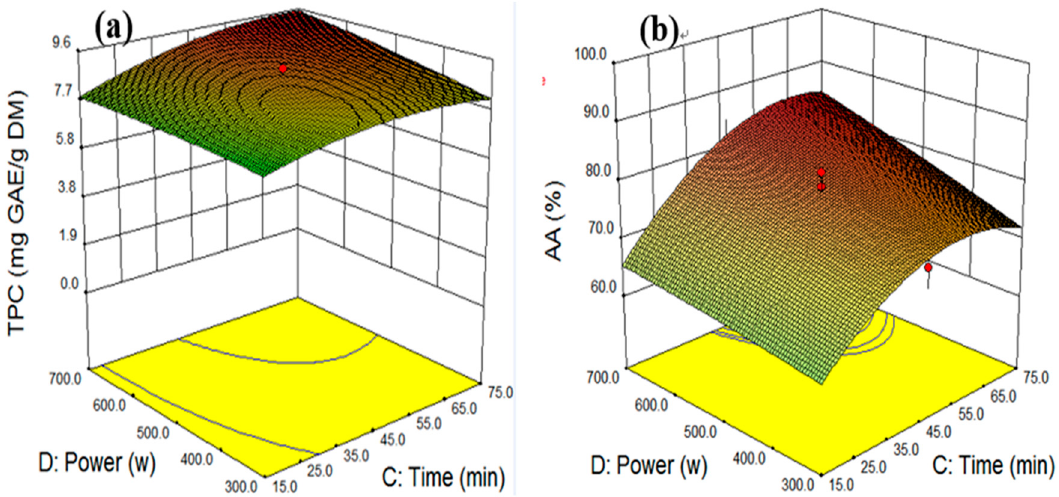
Figure 6. The interactive effect of extraction time and ultrasonic power on total phenolic compounds ( a ) and antioxidant activity ( b ) at constant levels of temperature 70 °C and ethanol concentration 58.3%.